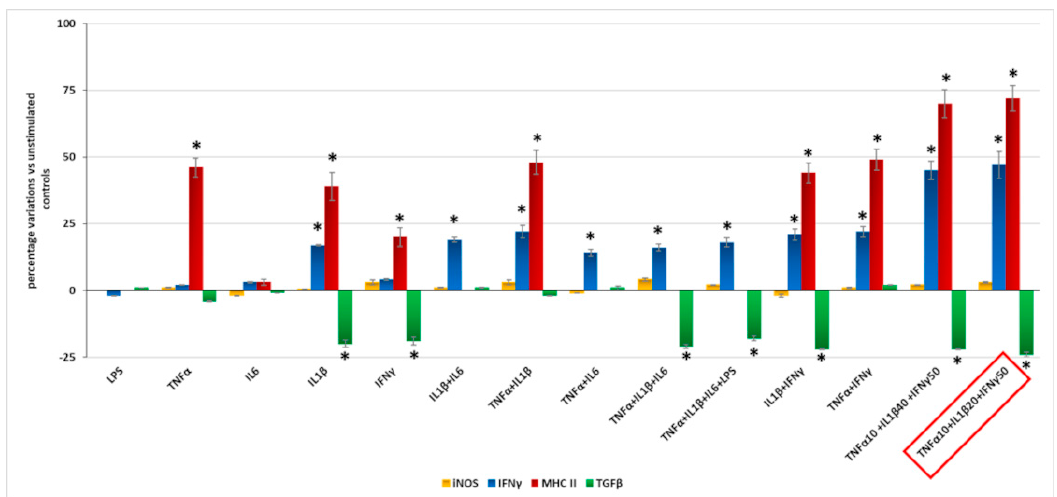
Figure 2. Factors and combinations tested to determine the best mixture to induce M1 activation in microglial cells. All factors are of human origin; concentrations and exposure times were chosen according to the literature. We first measured nitric oxide (NO) release in the supernatants through the Griess reaction, but it was undetectable in all cases (data not shown). Inducible nitric oxide synthase (iNOS), interferon- γ (IFN- γ ), MHC I (pro-inflammatory markers), and transforming growth factor- β (TGF- β , anti-inflammatory) were assessed by Western blotting in cell lysates. We selected the combination that exerted the maximum effects with the lowest concentrations: 10 ng/mL tumor necrosis factor- α (TNF α ) + 20 ng/mL interleukin-1 β (IL1 β ) + 50 ng/mL IFN γ . Lypopolisaccharide (LPS) had no effect on IM-HM cells. Data are expressed as percentage variations of unstimulated microglial cells. Mean of three experiments ± SD, * p < 0.05.